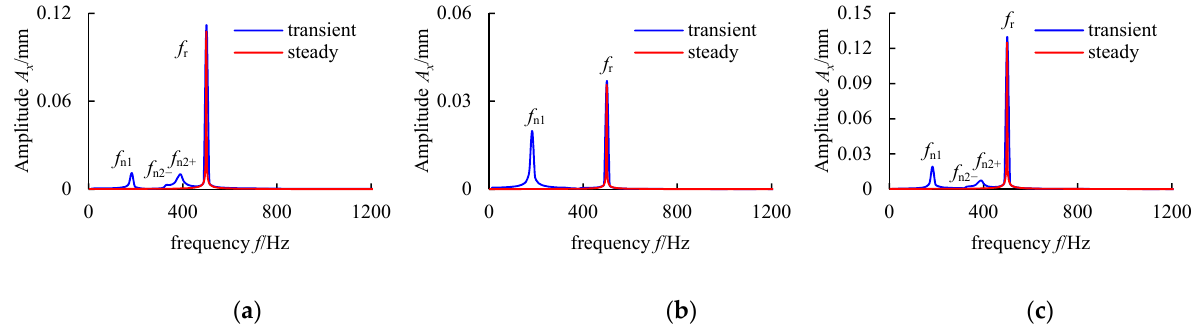
Figure 18. Frequency spectrums at different locations when the rotor operates at 30,000 r/min: ( a ) 1# bearing; ( b ) node 11 (C.G. position); ( c ) 2# bearing.